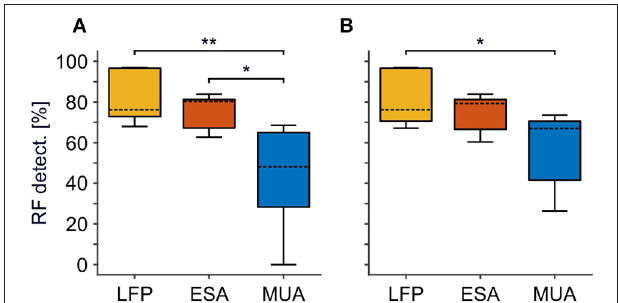
FIGURE 2 | Comparison of RF detection rate between LFP, ESA, and MUA. (A) Standard approach for thresholding MUA. (B) Optimized, iterative approach for thresholding MUA to maximize MUA-based detection rate. For each signal type, boxplots are based on detection rates of individual animals. Detection rates refer to the absolute number of RFs detected relative to the number of recording sites with a significant visual activation for at least one of the signals, merged over all animals. Boxes indicates the 25th and 75th percentile, dashed lines indicate the medians, and whiskers indicate the full range of data. Asterisks indicate statistical difference for α < 0.5% (*) and α < 0.05% (**), respectively.